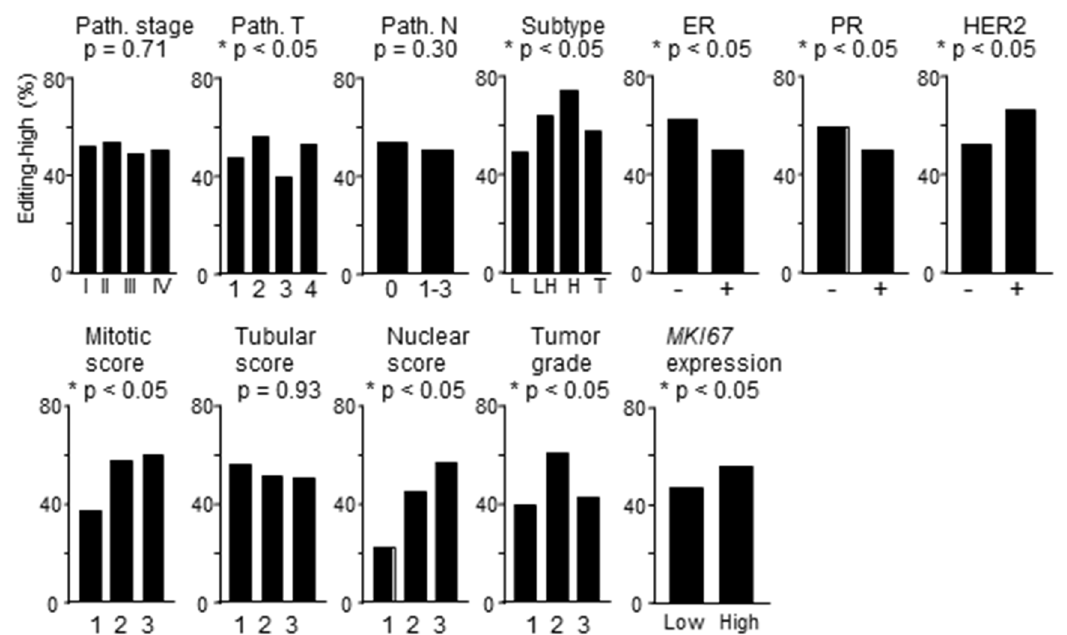
Figure 2. RNA editing and clinico-pathological features. Incidence of RNA editing-high tumors are plotted for different features of breast cancer. Pathological (Path.) stage and T and N TNM values are as per the American Joint Committee on Cancer staging system. Indicators of breast cancer subtypes are as follows: L, luminal type; LH, luminal-HER2; H, HER2; T, triple negative. For MKI67 gene expression, the median gene expression value was used to identify low and high groups. p -values were determined with Fisher (cid:48) s exact test. ER, estrogen receptor; PR, progesterone receptor; HER2, human epidermal growth factor receptor